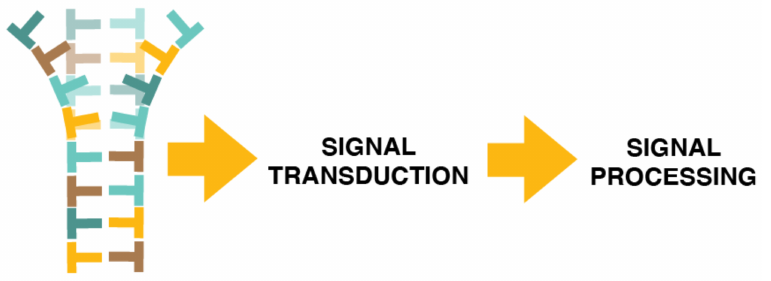
Figure 2. A simplistic illustration of the three components required in DNA-DNA hybridisation diagnostics: hybridisation of the target sequence to a DNA probe, a method to recognise that hybridisation, commonly referred to as the signal transduction method, and processing of that signal into a form compatible with end user requirement. Two of these components, the kinetics of DNA hybridization and the signal transduction method used to detect this hybridisation, determine the sensitivity of the